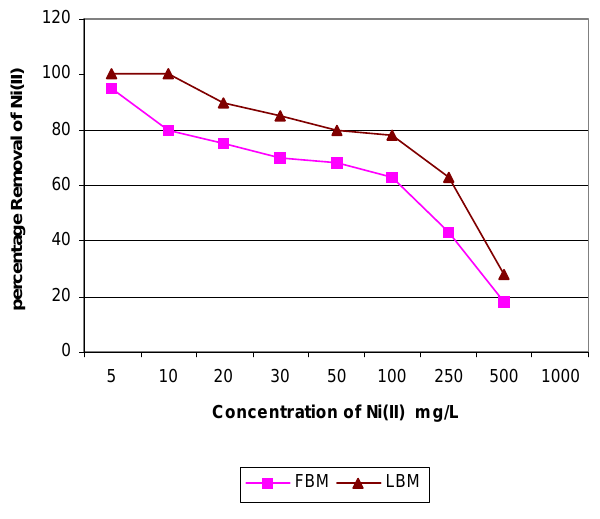
Figure 3: Effect of Initial metal ion concentration on the biosorption of Ni(II)